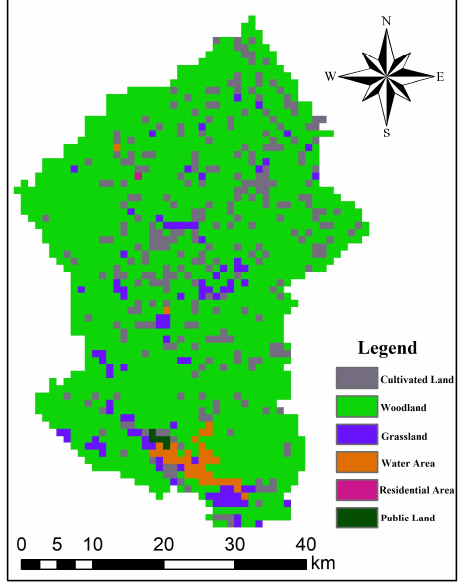
Figure 2. Land-cover distribution map in the Chengbi River basin.